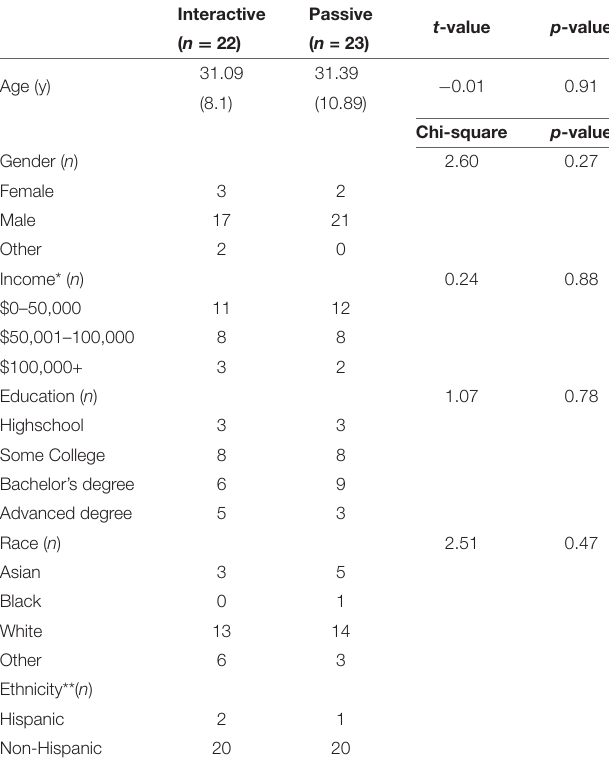
TABLE 1 | Participants’